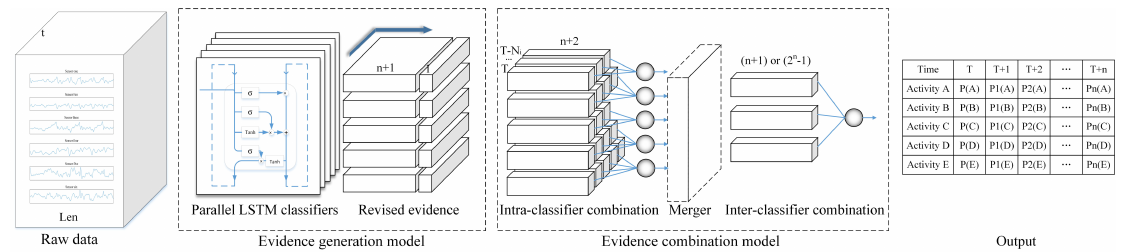
Figure 1. The stacked human activity recognition